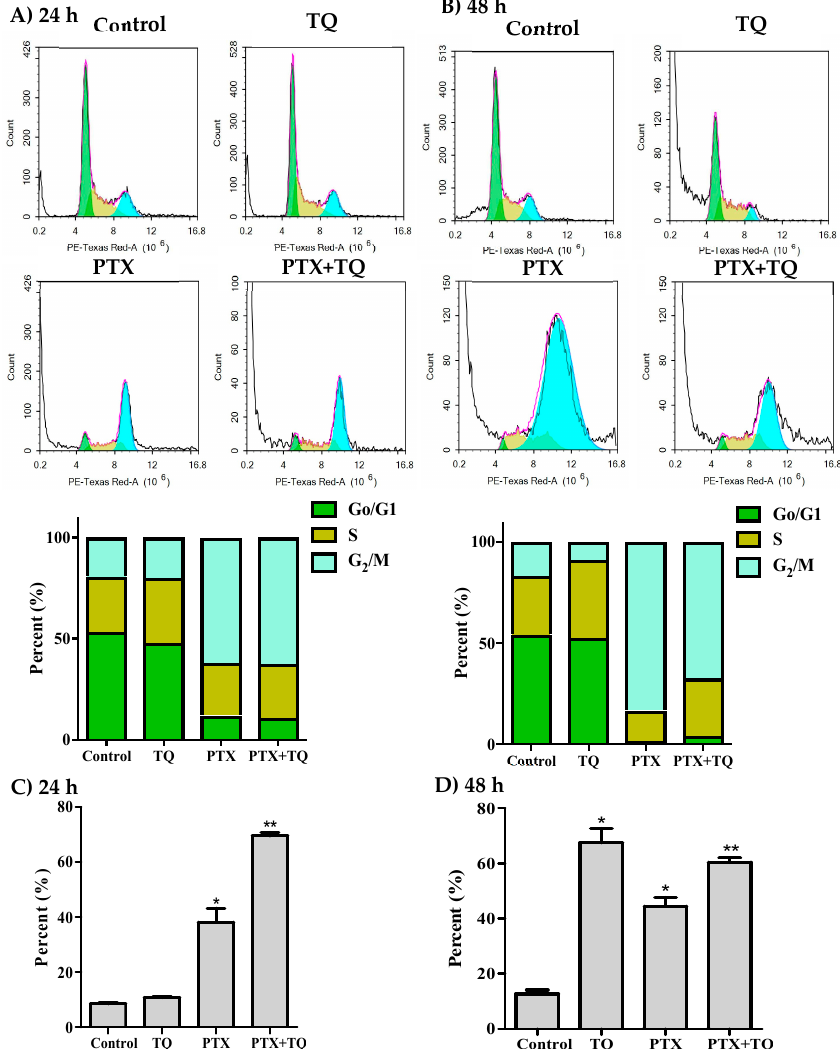
Figure 3. Effect of PTX, TQ, and their combination on the cell cycle distribution of T47D cells. Cells were exposed to PTX, TQ, or their combination for 24 h ( A , C ) or 48 h ( B , D ). Cell cycle distribution was determined using DNA content flowcytometry analysis and different cell phases were plotted as percentage of total events. Sub-G cell population was plotted as percent of total events ( C , D ). Data are presented as mean ± SD; n = 3. (*) significantly different from the control group. (**) significantly different from PTX treatment.